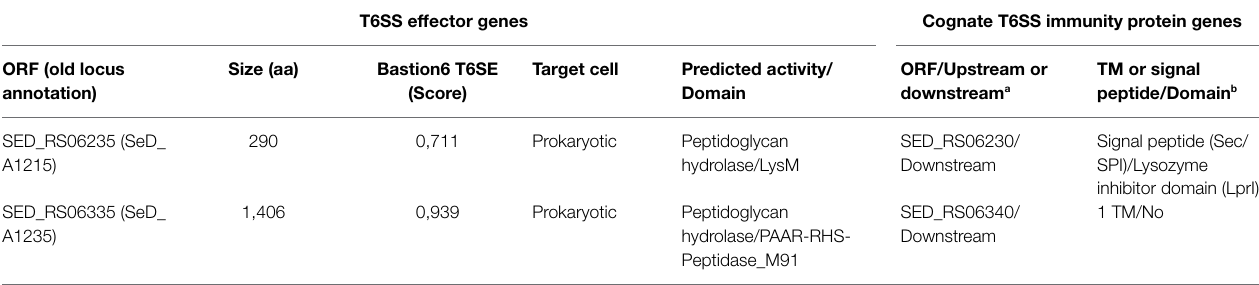
TABLE 4 | Novel predicted T6SS effectors and cognate immunity proteins encoded in SPI-19 of Salmonella Dublin CT_02021853. T6SS effector genes Cognate T6SS immunity protein